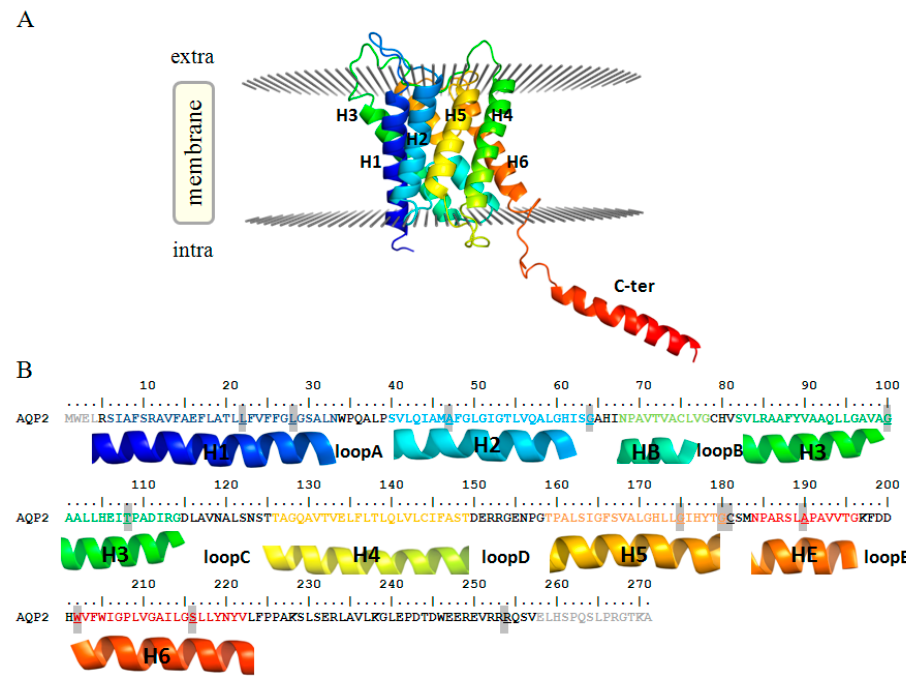
Figure 1. Human AQP2 monomer ( A ) structure (PDB ID: 4OJ2) and ( B ) sequence. In both panels, each helix is identified with the same colour and label. Mutated residues here examined are highlighted in the sequence ( B ). The N- and C-terminal residues not present in the PDB X-ray structure are shown in light gray.